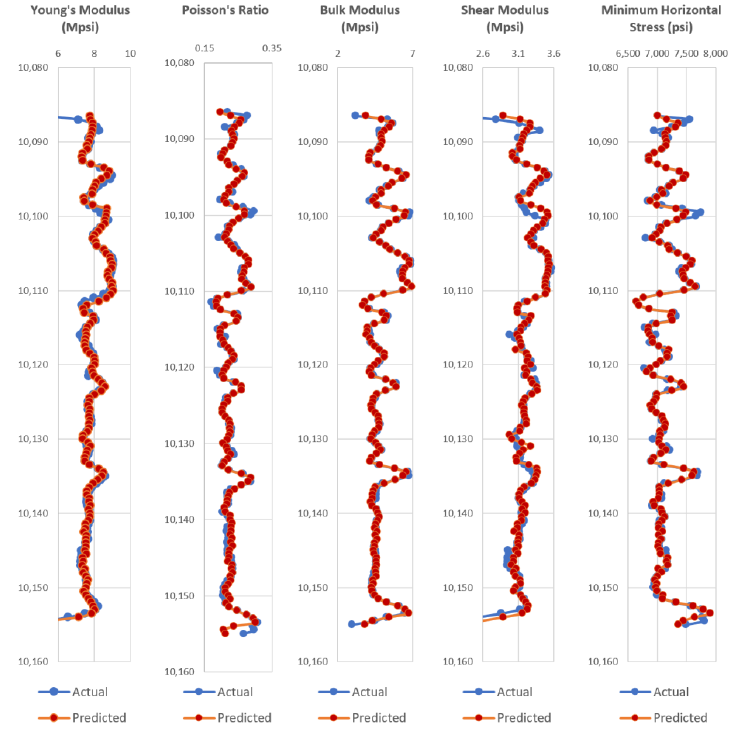
Figure A4. Actual and predicted geomechanical properties along with depth (feet) for test well 2 in Mountrail County for the Middle Bakken Formation.